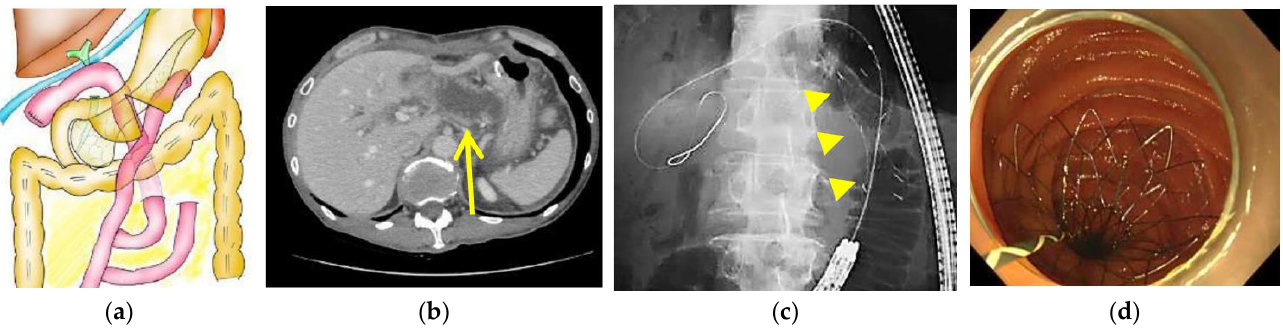
Figure 1. Endoscopic transluminal self-expandable metal stent placement for malignant afferent loop obstruction (Double bypass and type 1 obstruction case). ( a ) Illustration of bowel reconstruc- tion, ( b ) Contrast-enhanced computed tomography showing dilation of the afferent loop (yellow arrow), ( c ) Fluoroscopic view showing a metal stent (yellow arrowheads) placed using the through- the-scope technique, ( d ) Endoscopic view after stent deployment.